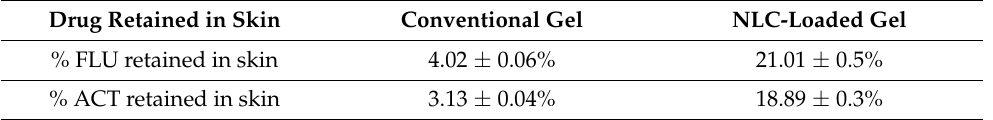
Table 4. Skin deposition study of FLU–ACT-coloaded NLC gel and FLU–ACT conventional